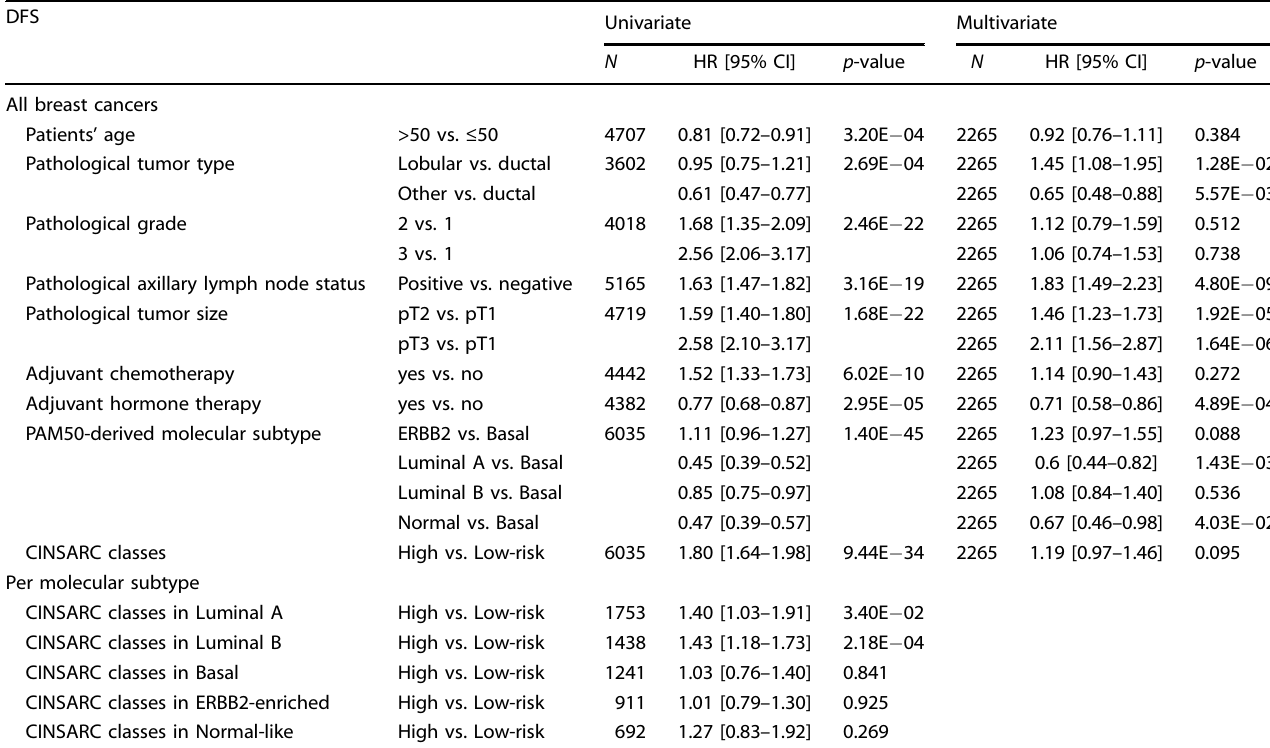
Table 1. Univariate and multivariate Cox regression analyses for DFS in breast cancer and per molecular